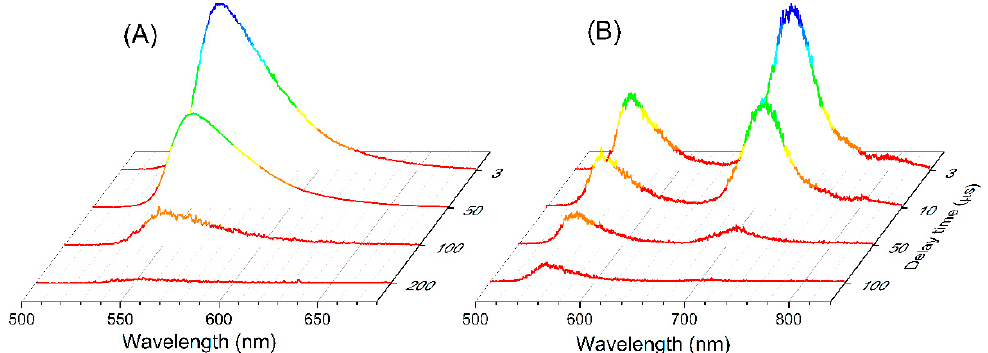
Figure 5. Time-dependent emission spectra of COO -BODIPY 2 in ethyl acetate ( A ) and n -propyl iodide ( B ) measured under ambient conditions after laser photo-excitation at 532 nm. Optically matched solutions were used.